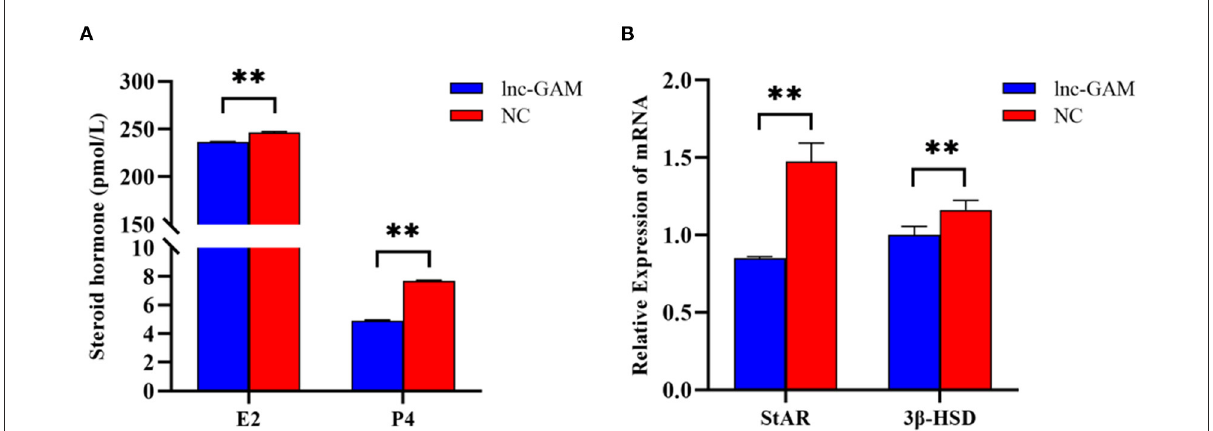
FIGURE9 lnc-GAM effects on steroid secretion by POGCs. (A) Estradiol and progesterone contents in the supernatant of cells with different lnc-GAM expression profiles. (B) The mRNA levels of steroidogenesis-related factor were estimated by quantitative real-time PCR. GAPDH served as the internal reference. The lnc-GAM refers to pcDNA3.1-lncGAM, and NC refers to pcDNA3.1, the same blow. ** P <